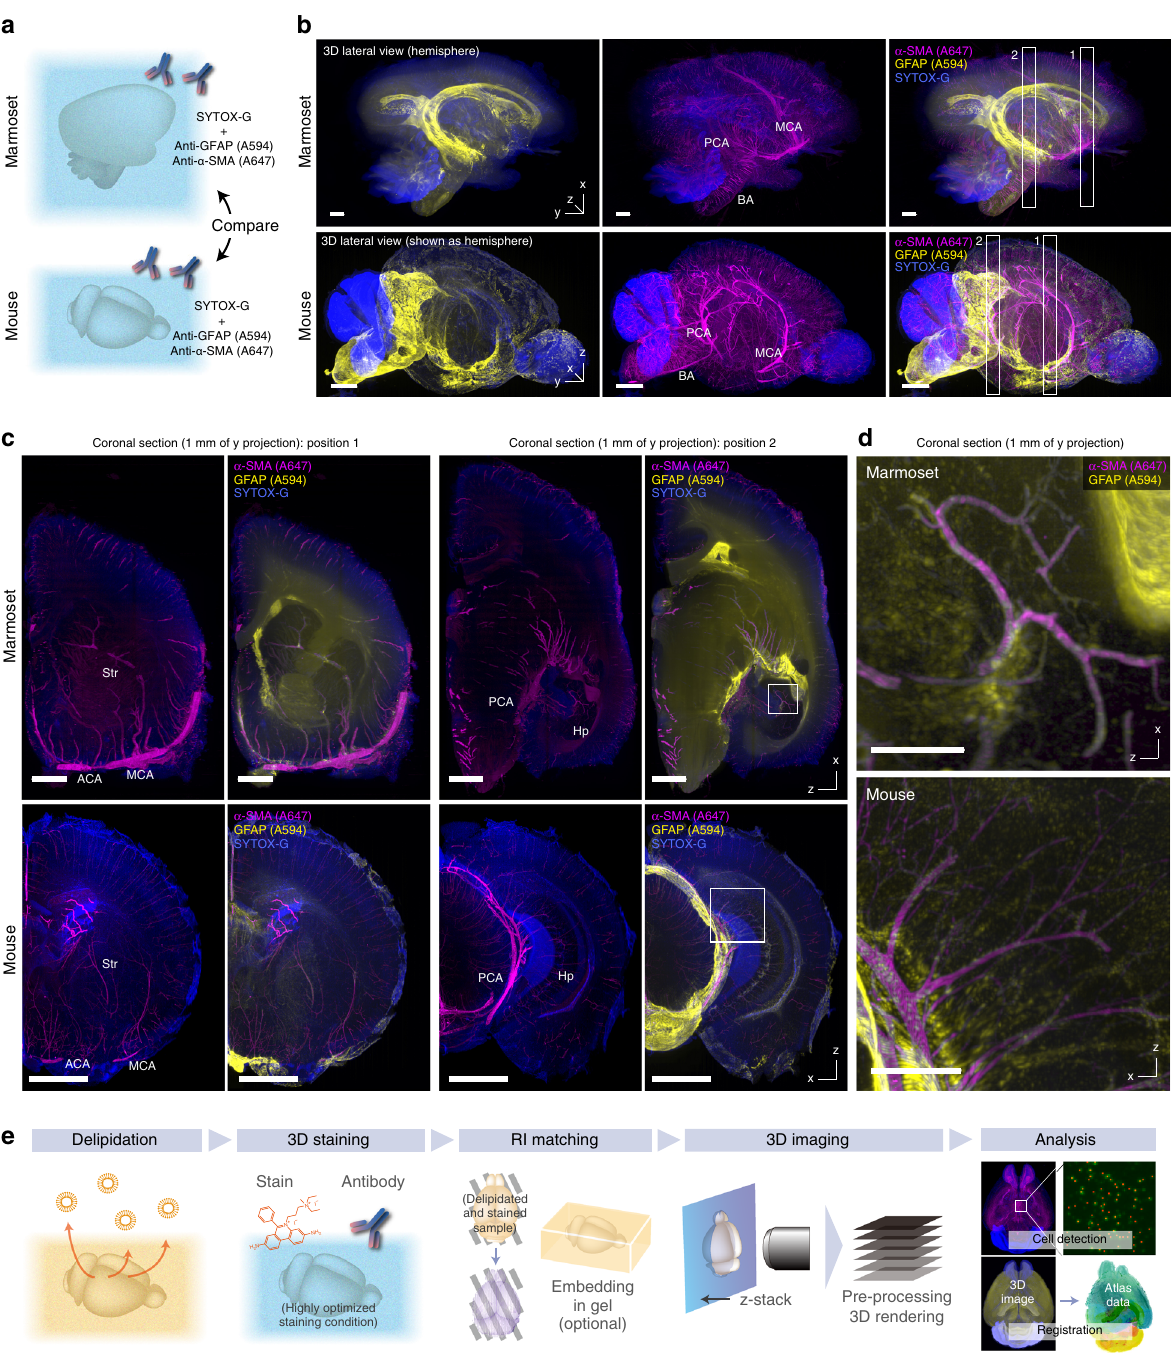
Fig. 9 CUBIC-HV enables organ-level comparison of rodent and primate brains. a Experimental schema of the whole-organ comparison analysis of rodent and primate brains. b Comparison of an adult marmoset brain hemisphere with the whole adult mouse brain (only the right hemisphere is depicted), costained with SYTOX-G, GFAP (A594), and α -SMA (A647) antibodies. Note that the orientations were different between samples. Images were reconstituted with Imaris software. Voxel sizes 16.4 × 16.4 × 16 μ m 3 (for marmoset brain) and 8.3 × 8.3 × 9 μ m 3 (for mouse brain). MCA middle cerebral artery, PCA posterior cerebral artery, BA basilar artery. Scale: 2 mm. c Reconstituted coronal sections of hemisphere images in b , showing the distributions of corresponding vessel structures and GFAP-positive cells. Note that the different orientations of the sections ( z – x and x – z for the marmoset and mouse samples, respectively) could be compared because of the almost isotropic voxel resolution of the z -stack images. ACA anterior cerebral artery, Str striatum, Hp hippocampus. Scale: 2 mm. d Magni fi ed images at the positions indicated in c , showing the similar distributions of vessel-associating GFAP- positive cells in the hippocampus. Voxel size in both images 8.3 × 8.3 × 9 μ m 3 . Scale: 0.5 mm. e Flowchart of staining-based whole-organ imaging and image analysis on